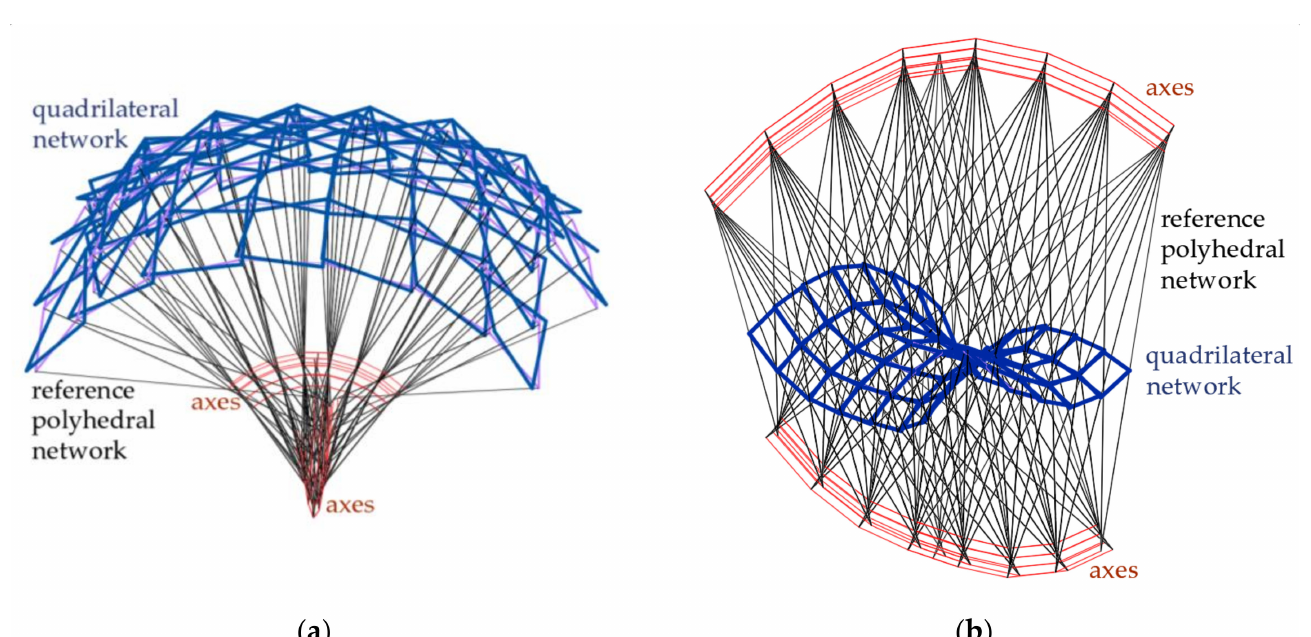
Figure 22. Two shell roof structures with eaves meshes arranged compatible with a regular surface of characterized by: ( a ) the positive Gaussian curvature, ( b ) the negative Gaussian curvature defined by means of two various polyhedral reference